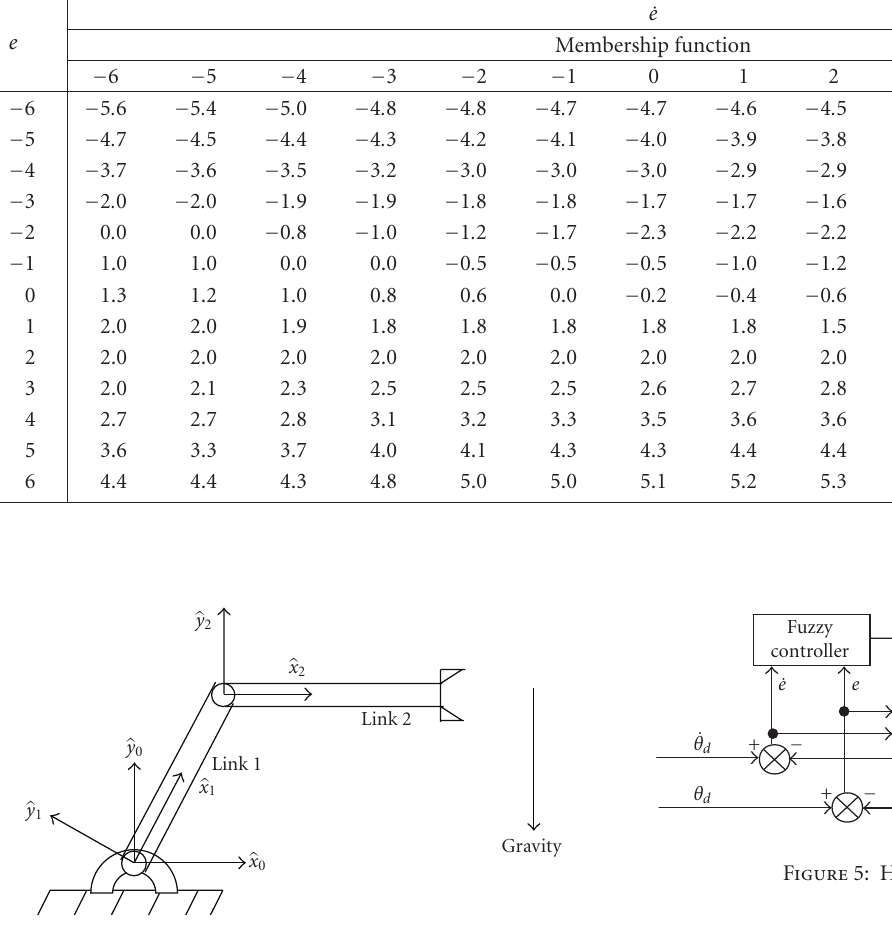
Figure 4: Manipulator used for simulations.